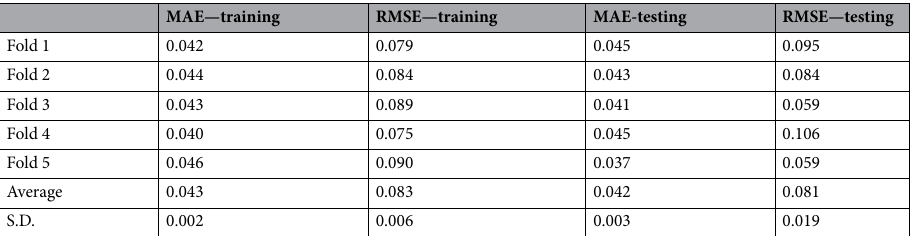
Table 1. Performance of the proposed model for measuring changes in cell areas. This table presents arithmetic means and standard deviations of MAE and RMSE obtained from the 5-fold cross-validation. The left two columns are the results for the training data, and the right two columns are for the testing